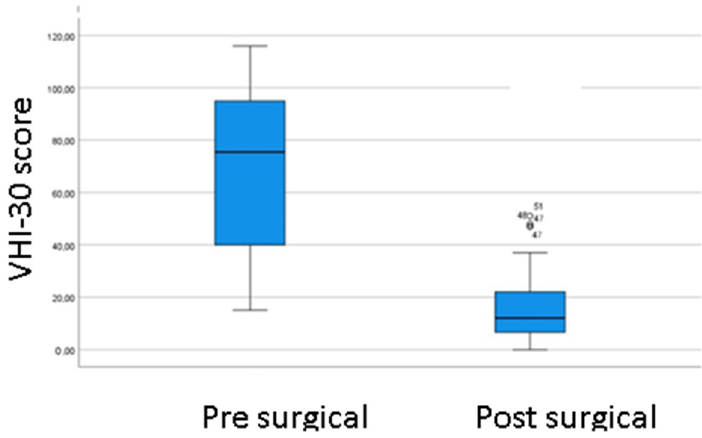
Figure 7. Comparison of the pre ‐ and post ‐ surgical VHI ‐ 30 score.